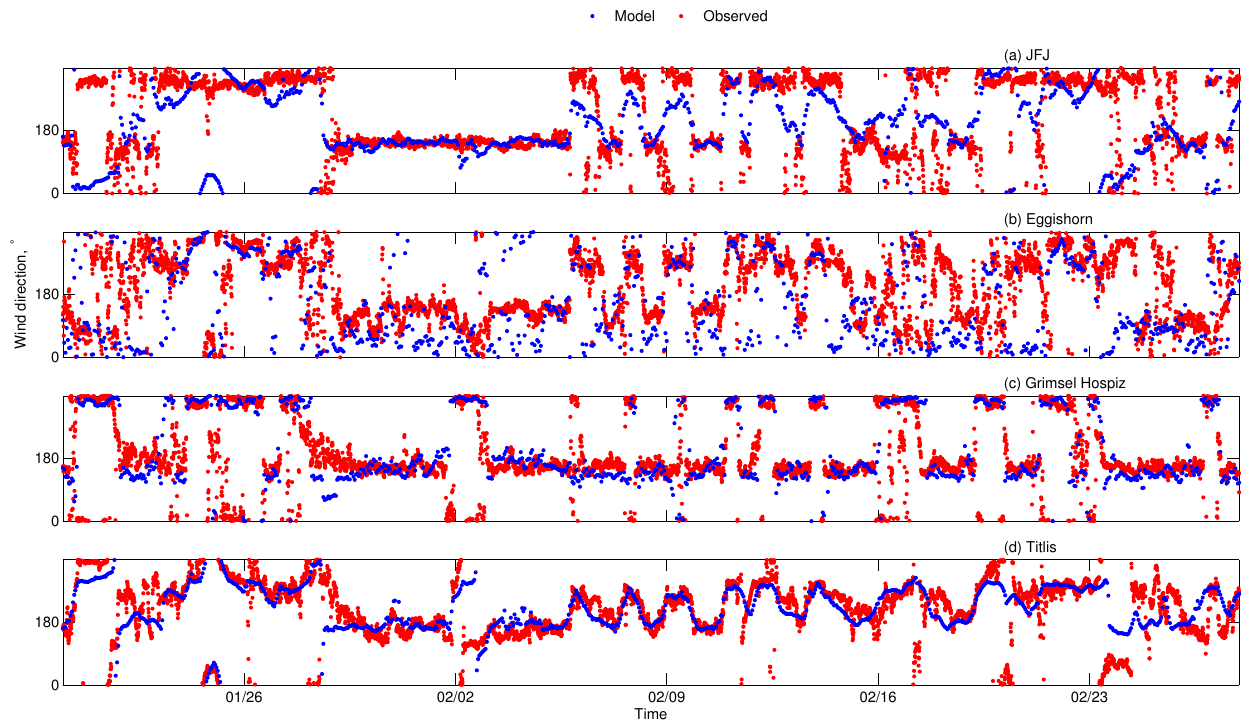
Figure 5. A comparison of the wind direction at four MeteoSwiss observation stations with the WRF control simulation during the INUPIAQ field